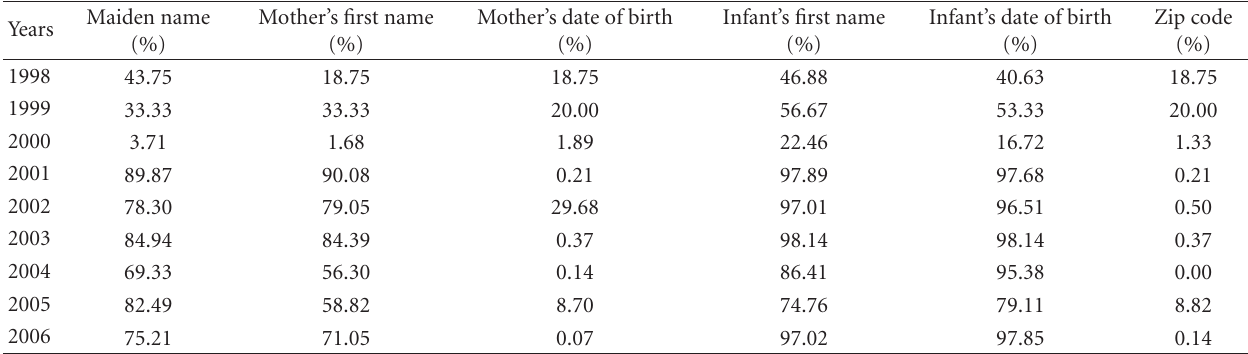
Table 2: Percentages of missing data for each identification item, among false positives, for each year.